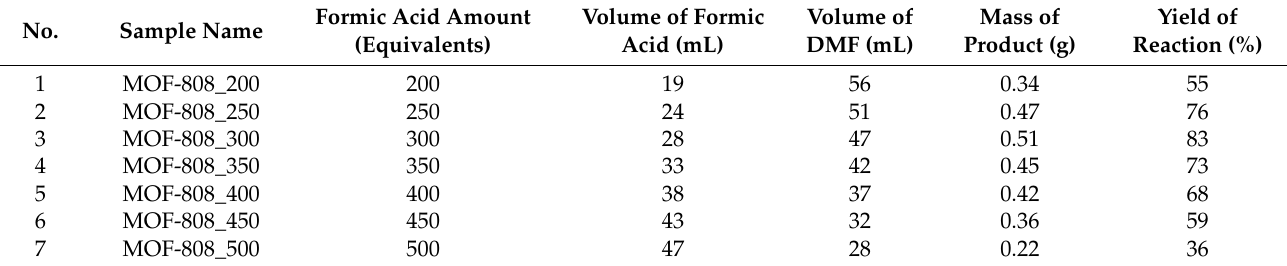
Table 1. Synthesis conditions of MOF-808 with different formic acid